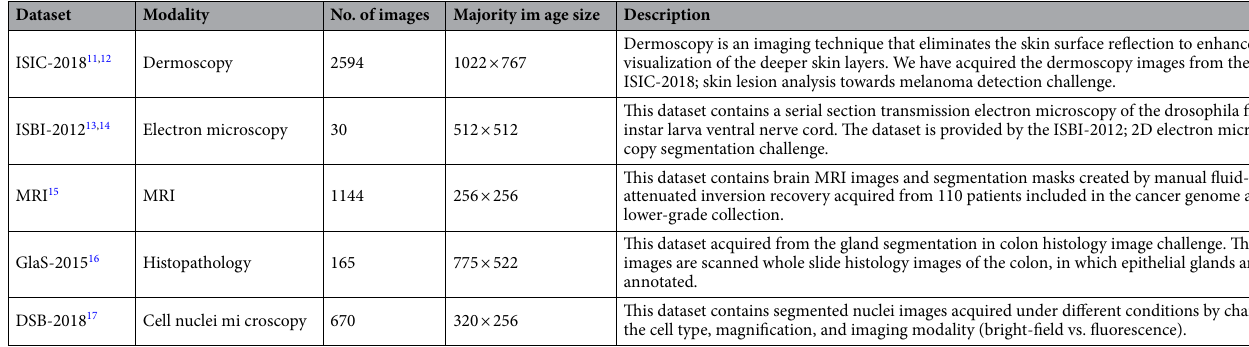
Table 1. Five publicly available biomedical imaging datasets used in this study for the semantic segmentation. Note that the images are available with varying sizes within some